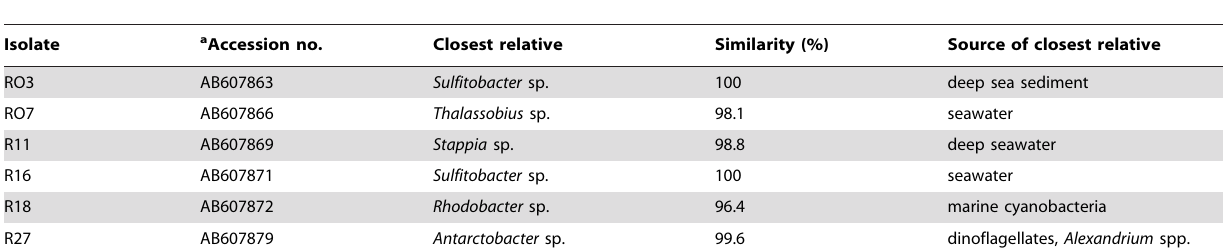
Table 2. Phylogenetic sequences of culturable Roseobacter clade isolated from N. oculata culture.